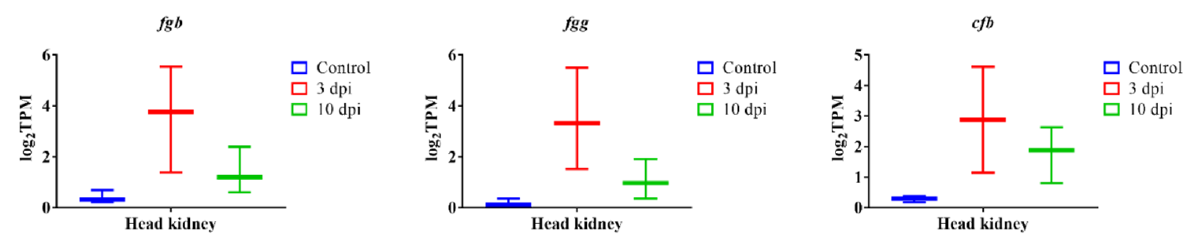
Figure 8. Most significant DEGs in the head-kidney after A. salmonicida infection in lumpfish. Bar plots represent the expression pattern (log 2 TPM) of fibrinogen beta and gamma chain ( fgb and fgg ), complement factor B ( cfb ).